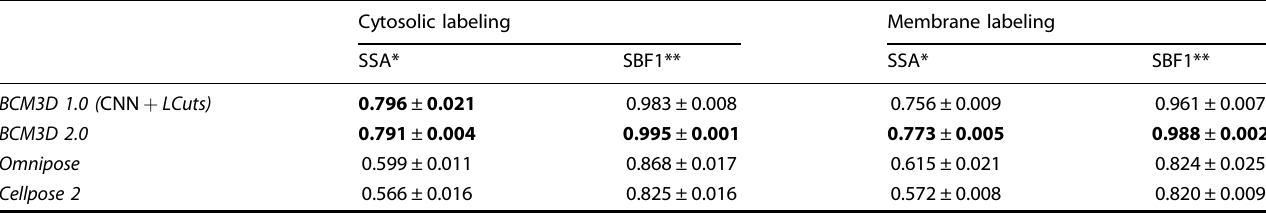
Table 1. Quantitative comparison of single-cell level segmentation accuracy between BCM3D 1.0 and BCM3D 2.0